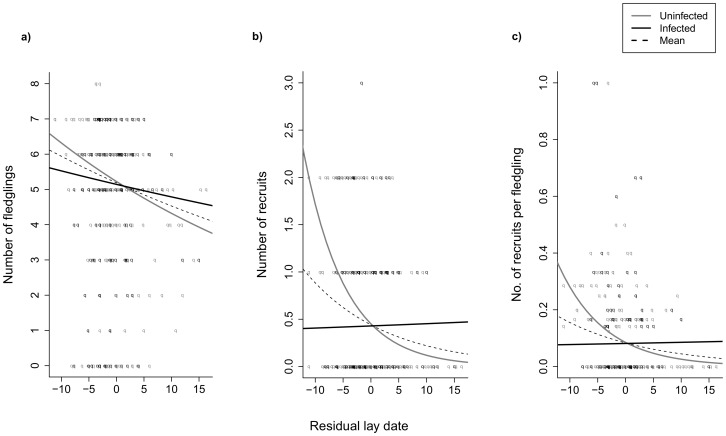
Comparison of the seasonal pattern of reproductive performance between female collared flycatchers infected with blood parasites (solid black line), uninfected females (solid grey line) and the mean for all analyzed females (dashed black line) breeding on the Swedish island of Öland.It was plotted with model-averaged (ΔAICc<2) prediction lines using shrinkage estimates: a) number of fledglings, b) number of recruits, c) number of recruits per fledged offspring. Uninfected females show a typical seasonal decline in reproductive success where they rear more fledglings and recruits early in the season, whereas females infected with Haemosporidia parasites show an opposite pattern. As a result, uninfected females rear proportionally more recruits per fledgling early in the season. Infected females, however, experience a much shallower decline in recruits as the breeding season progresses, and thus recruit the same number of offspring. Despite altered pattern among infected females, the trend for the population remains negative.